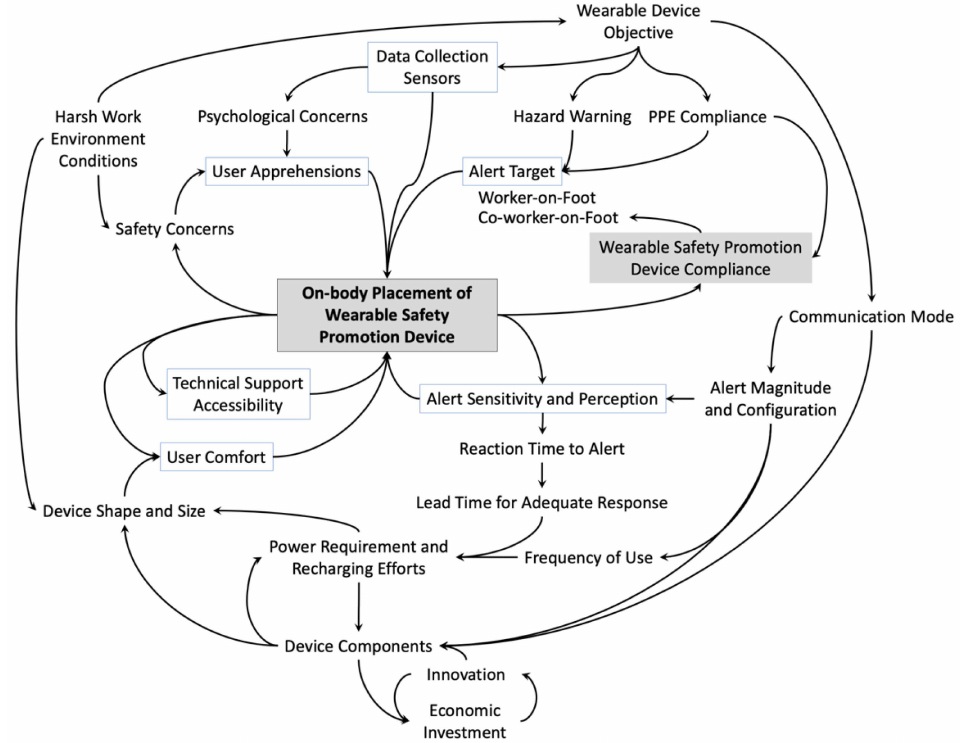
Figure 7. The prominence of on-body placement as depicted through the ‘on-body placement loop diagram for wearable safety promotion